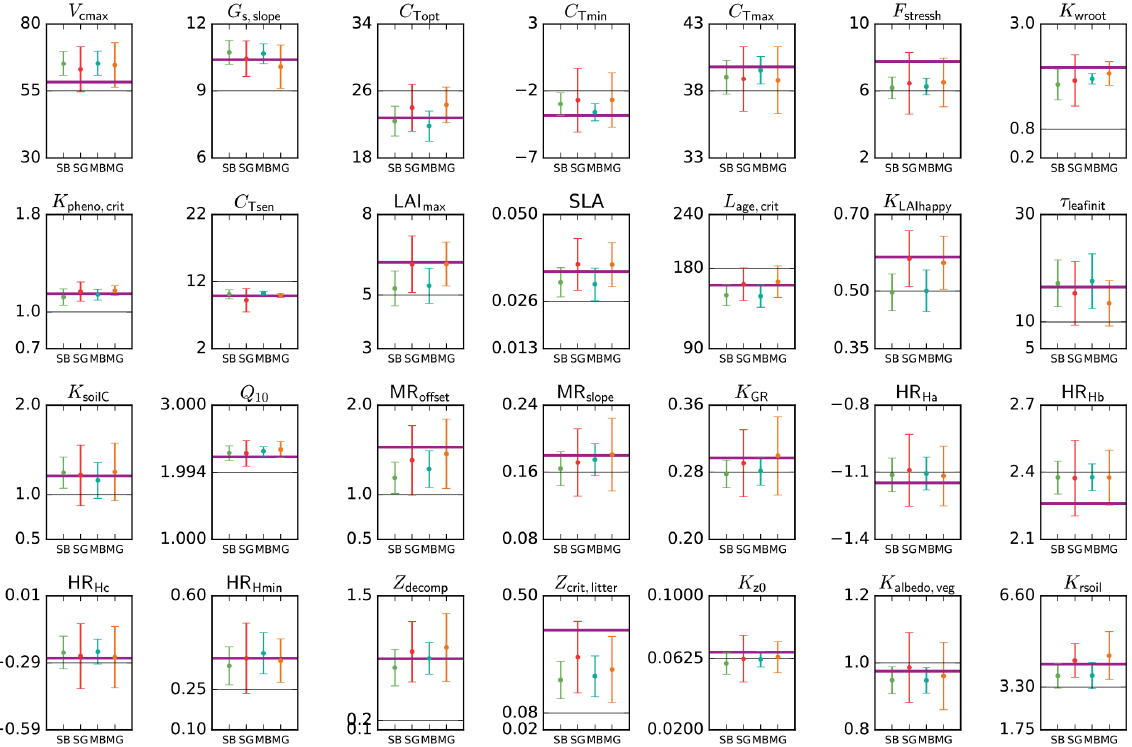
Figure 4. Parameter estimates from a pseudo-data experiment for the temperate deciduous broadleaf forest PFT. Results for the four different methods ( S BFGS , SB; S Genetic , SG; M BFGS , MB; and M Genetic , MG) are displayed: mean value and standard deviation across 16 random first-guess tests. The thick horizontal purple lines correspond to the “true” parameter values (defined randomly); the thin grey horizontal lines correspond to the prior value, which is equal to the default ORCHIDEE model value. The vertical axis limits represent the range of parameter